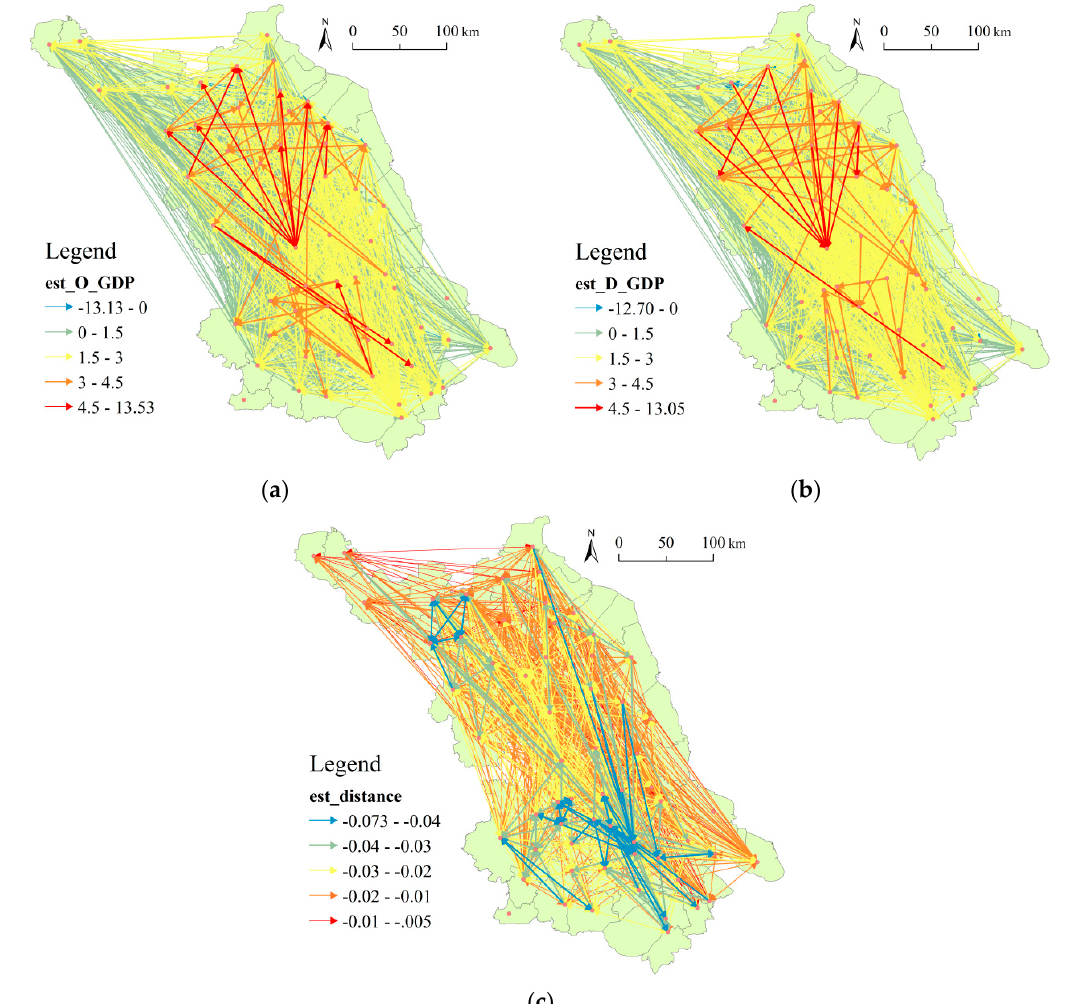
Figure 8. Distributions of three parameter estimations with GWOLS model. ( a ) OGDP; ( b ) DGDP; ( c ) distance.